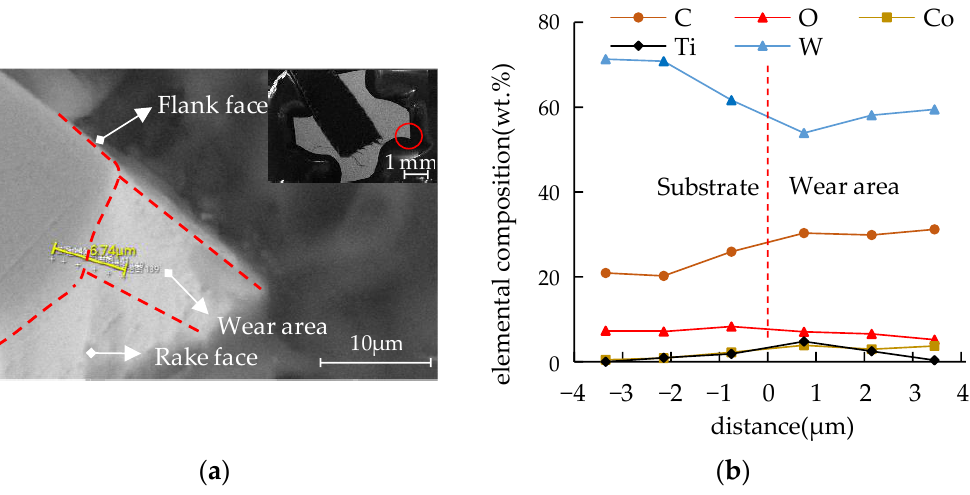
Figure 11. Element diffusion along the tool wear section. ( a ) SEM image of the cutting edge; ( b ) Element diffusion curve along the wear area.